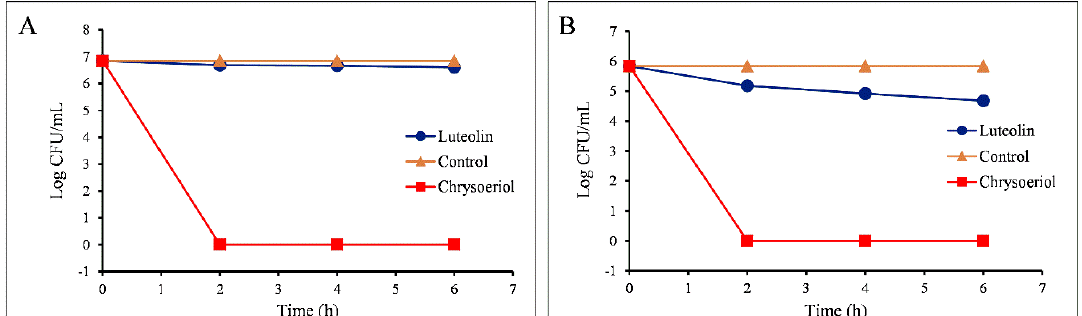
Figure 6. The antibacterial activity of luteolin and chrysoeriol against ( A ) Staphylococcus aureus and ( B ) Proteus hauseri . The number of colonies is expressed in terms of log CFU/mL.